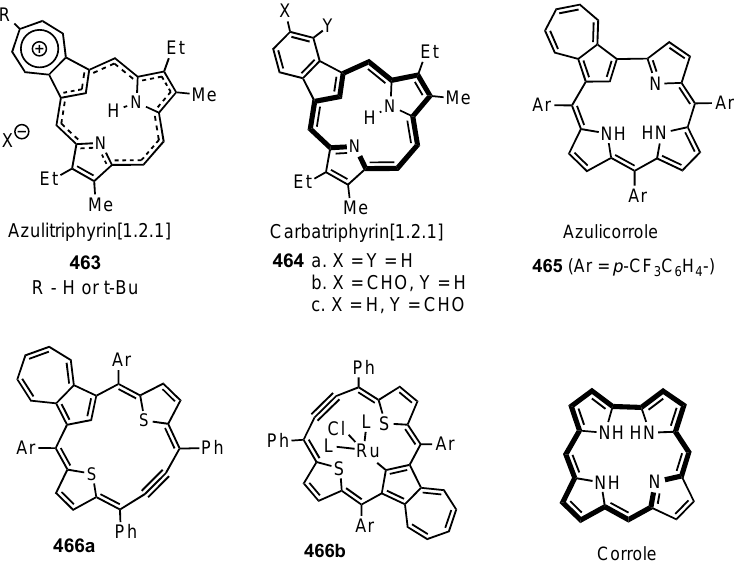
Figure 12. Examples of contracted carbaporphyrinoids and the structure of corrole. Corroles (Figure 12) are contracted porphyrins with only three bridging carbons.